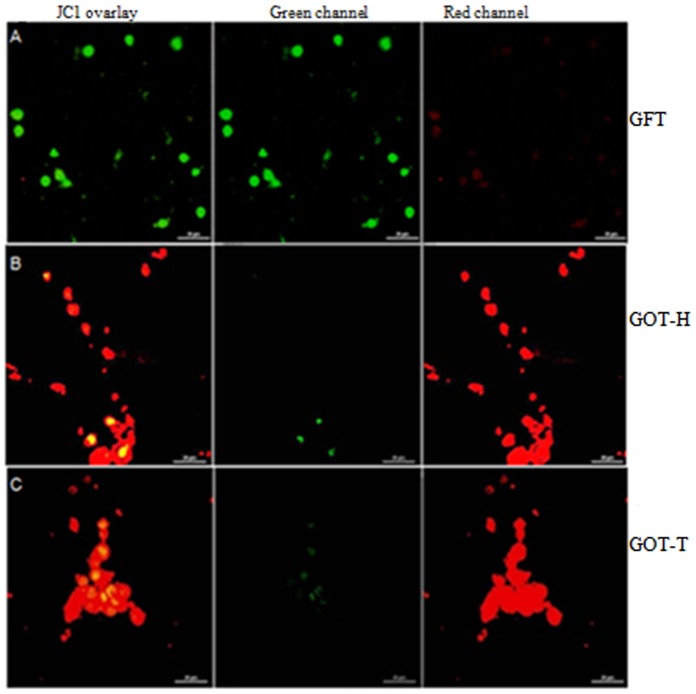
Potential-dependent mitochondrial JC1 staining.Images of mitochondrial JC-1 fluorescence in granulosa cells are presented in Figs. 10 A–C. Granulosa cells obtained from follicle-deficient ovaries in the GFT group (Fig. 10A) show green fluorescence indicating disruption of mitochondrial membrane potential. The follicle-deficient host ovary (GOT-H) (Fig. 10B) exhibits shifting from green to reddish orange fluorescence and re-establishment of mitochondrial membrane potential following transplantation of ovary (GOT-T) (Fig. 10C) that also shows reddish orange florescence in most of the cells due to strong JC-1 aggregation denoting high mitochondrial membrane potential. Each image is one representative of 9 replicates; 3 replicates from each granulosa cell pool, and each pool represented by ovaries from 6-8 rats.